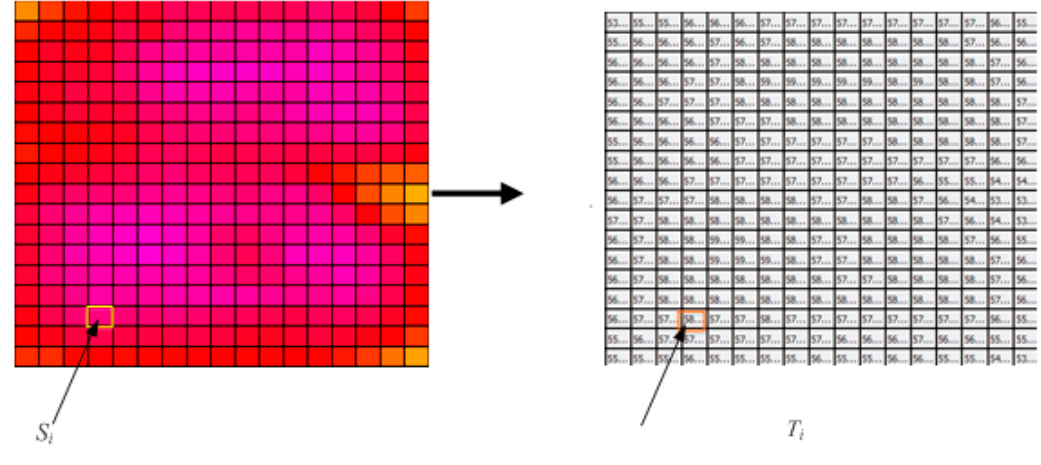
Figure 3. Illustration of gray level distribution corresponding to temperature image.